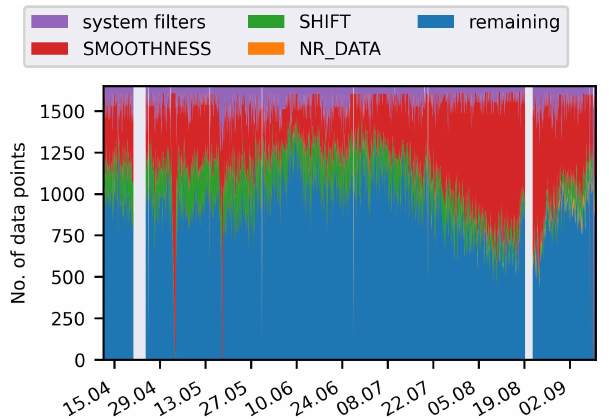
Figure 6. Number of data points retained for 1Hz after application of all filters denoted with corresponding labels in the text. The spe- cific nature of the filters is explained in the text; “system filters” refers to all system-specific